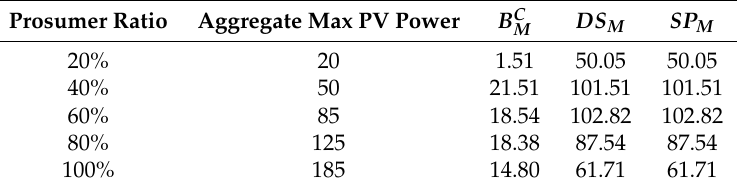
Table 2. The results for M in £ for the setting with perfect predictions without storage. At the end of the period, B C is in a deficit state with all prosumer ratios. DS M and SP M are highest with prosumer M ratios between 40 and